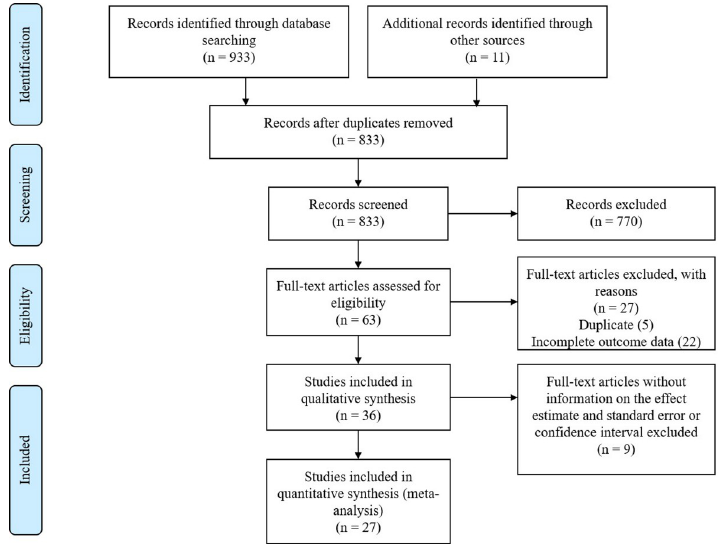
Fig 1. PRISMA flow diagram. A total of 36 studies were identified for inclusion in the reviews, after a two-stage screening process. Twenty-seven studies among them were included in meta-analyses.